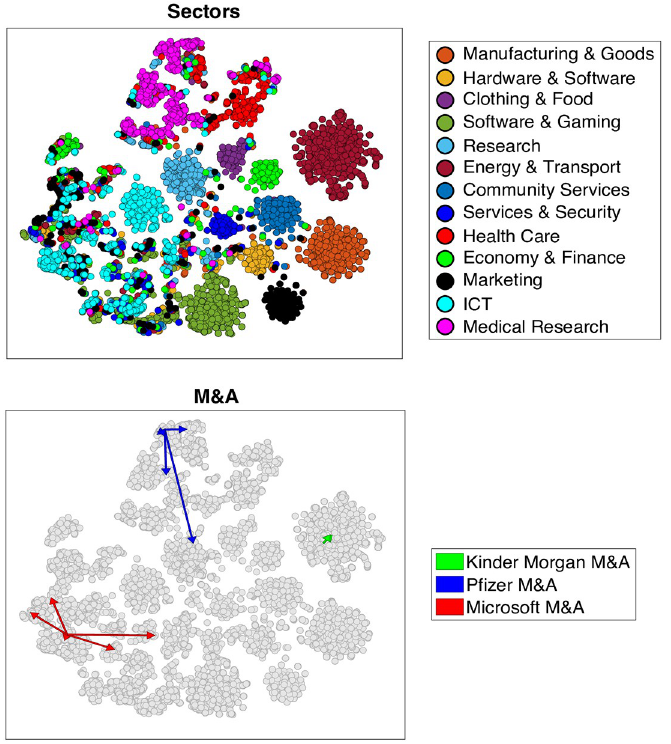
Fig 1. CCS Jaffe + Sectors ( α = 0.1). In the CCS (Continuous Company Space) representations above each point represent a company. On the upper panel, points are colored according to companies’ industrial sectors. The effects of the information on the industry are visible from the clustering of firms of the same color. On the lower panel, we represent on the CCS some acquisitions performed by three large companies as arrows from the acquirer firms to the targets. This is an example of how acquisitions are likely to be done locally in this